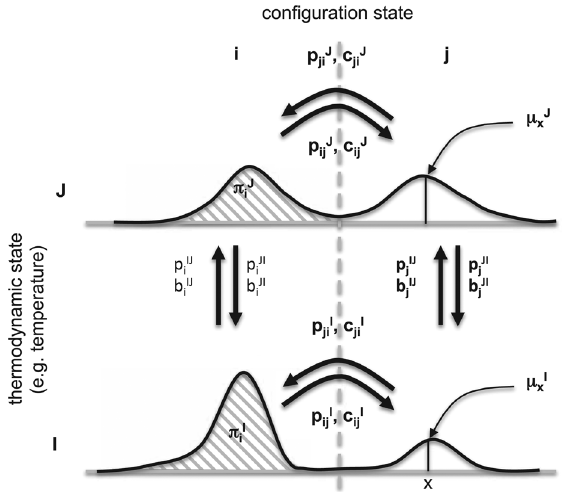
FIG. 1. Illustration of the expanded transition process in xTRAM and the symbols used: c I and p I are transition counts ij ij and probabilities between different configuration states i , j at the same thermodynamic state I . b IJ and p IJ are transition counts and i i probabilities between different thermodynamic states I , J at the same configuration state i . The latter are constructed such that reweighting to the equilibrium densities μ I x , μ J x of configurations x at different thermodynamic states I , J ,